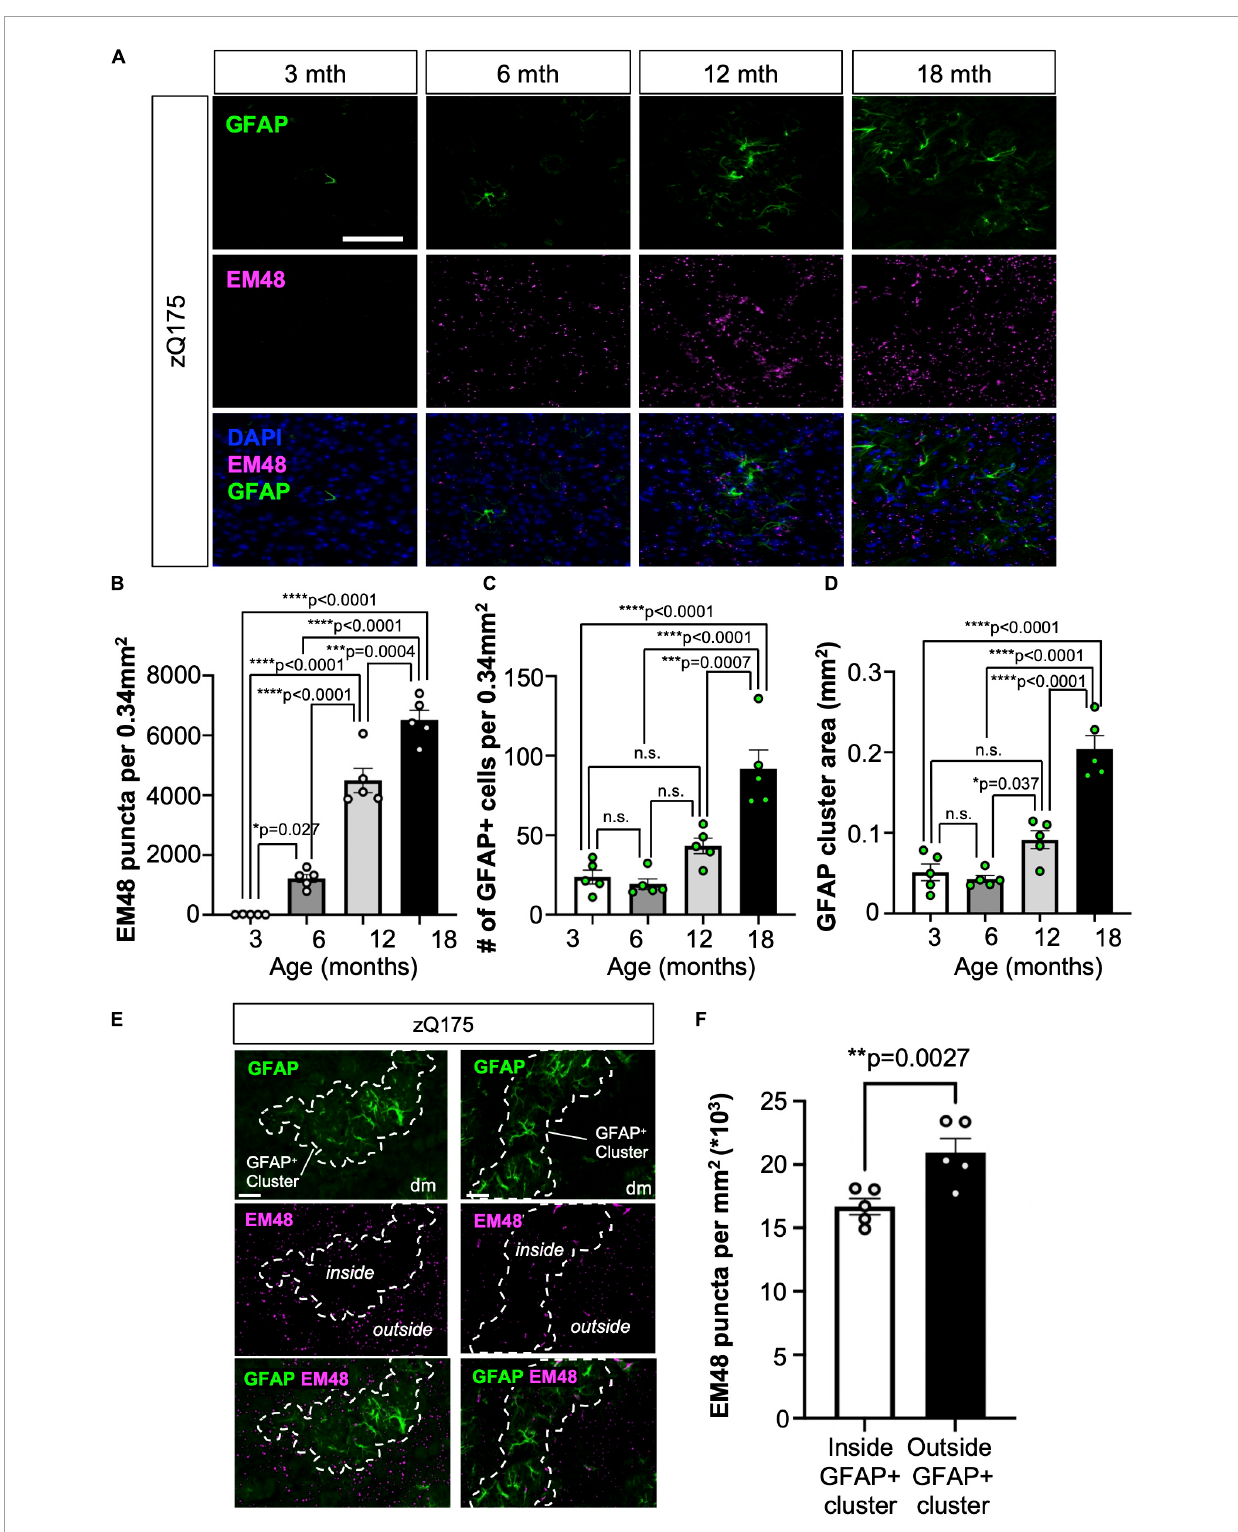
FIGURE4 GFAP + astrocytes clustered in dm striatum with low HTT aggregate load in zQ175 mice. (A) Representative images from zQ175 mice at 3, 6, 12, 18, and 22 months showing GFAP and HTT aggregation (EM48) in the dm striatum. DAPI stains nuclei. Scale bar is 100 µ m. Number of EM48 puncta per 0.34 mm 2 (B) , number of GFAP + cells per 0.34 mm 2 (C) , and the mean area (mm 2 ) of GFAP + astrocyte clusters (D) in the striatum of 3-, 6-, 12-, and 18-month-old zQ175 mice analyzed using confocal images ( n = 5 mice/age). (E) Representative immunofluorescence images showing GFAP and EM48 in the dm striatum of zQ175 mice at 18 months. Dotted lines surround GFAP + astrocyte clusters occupying areas of low HTT aggregate load. Scale bar is 50 µ m. (F) Number of EM48 puncta per µ m 2 inside GFAP + clusters and outside GFAP + clusters in 18 month old zQ175 mice analyzed using confocal images ( n = 5 mice/genotype). Ordinary one-way ANOVAs with Tukey’s multiple comparisons test [ (B) F = 123.4, df = 3; (C) t = 22.91, df = 3; (D) t = 42.27, df = 3] and Paired student’s t -test [ (F) t = 6.591, df = 4]. Error bars denote mean ± SEM. * p < 0.05, ** p < 0.01, *** p < 0.001, **** p < 0.0001. p -values > p = 0.05 are shown as